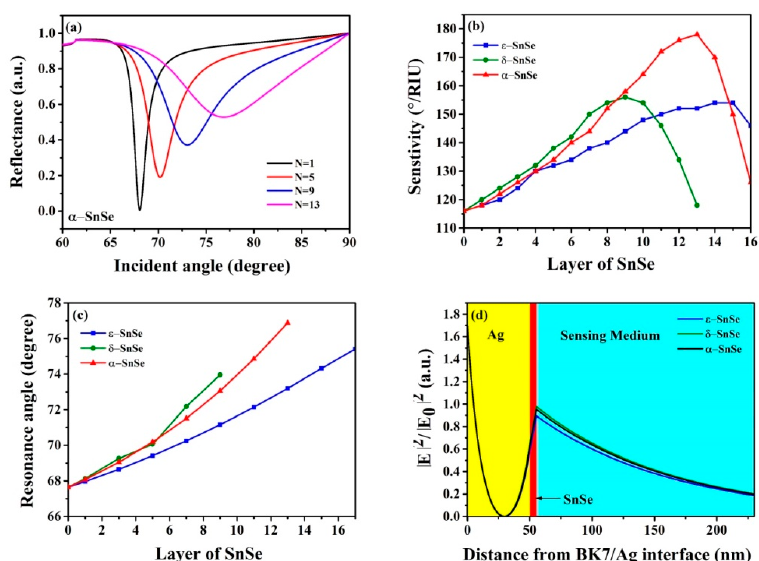
Figure 5. ( a ) Change of the reflectance of α -SnSe biosensor, ( b ) variation of sensitivity with respect to different numbers of SnSe allotrope layers, ( c ) change of resonance angle with respect to different layer numbers of SnSe allotropes, ( d ) the electric field distribution for the proposed SPR sensor. Table 1. Change in different Ag thickness ( d Ag ), layer numbers ( L ), highest sensitivity ( S ), minimum resonance angle ( θ min ), resonance angle change ( ∆ θ ), and the smallest reflectivity ( R min ) for the SnSe allotrope-based SPR biochemical sensors at n s = 1.33.